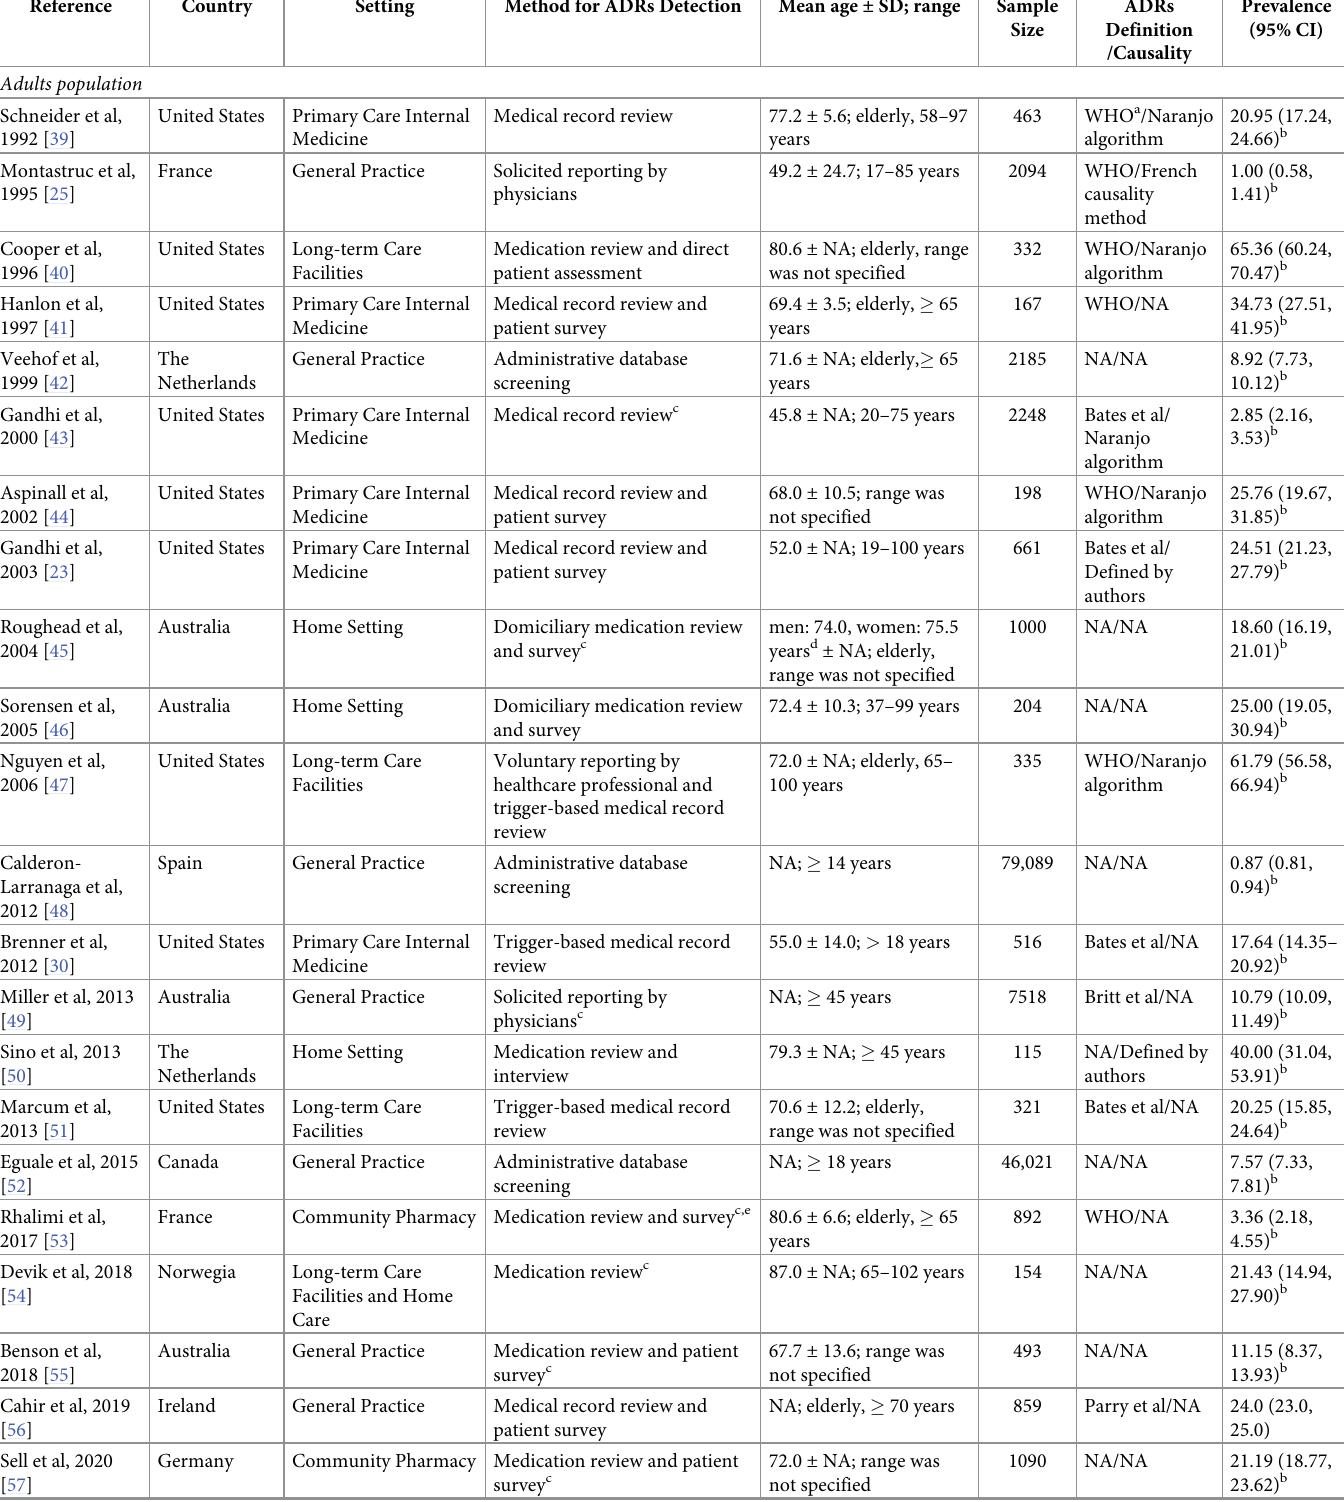
Table 1. General characteristics of included